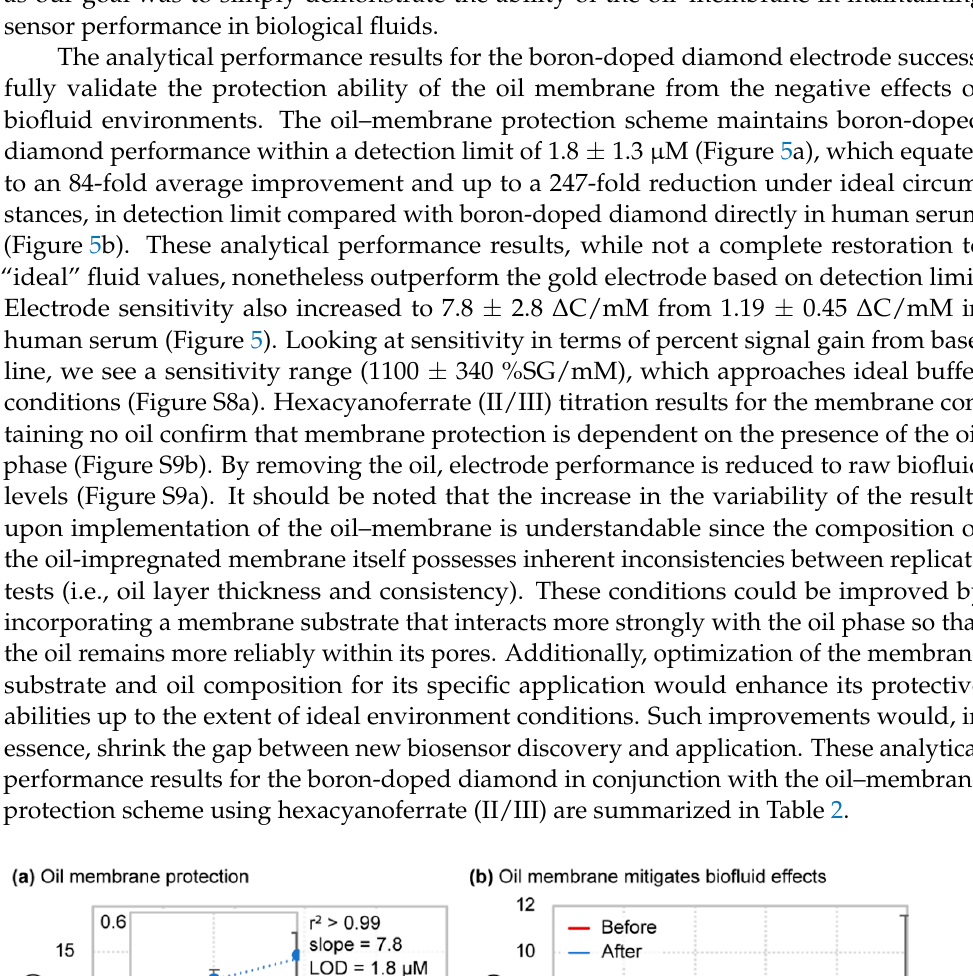
Table 2. Summary of the analytical performance of boron-doped diamond with and without inte- grated oil–membrane protection in human serum for hexacyanoferrate (II/III) titration.